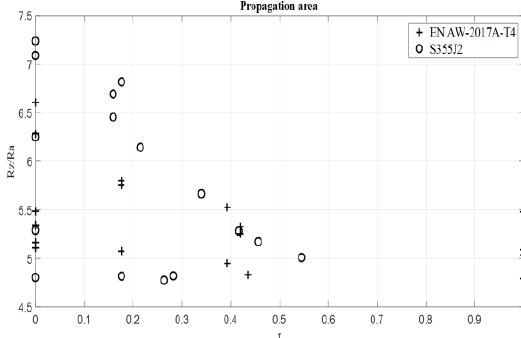
Fig. 10. The Rz/Ra factor relationship to r parameter, for initiation area.